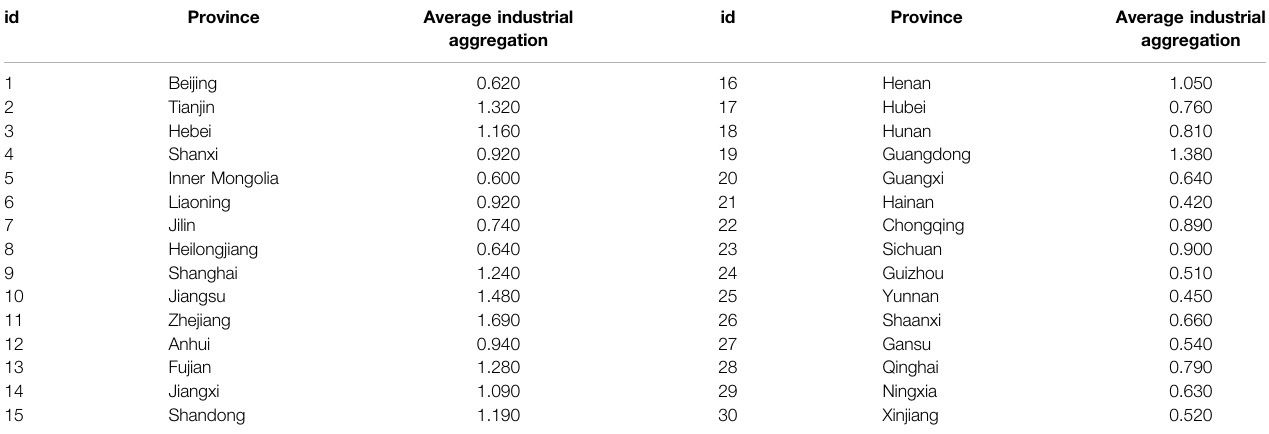
TABLE 9 | Average Industrial Aggregation (2009 –